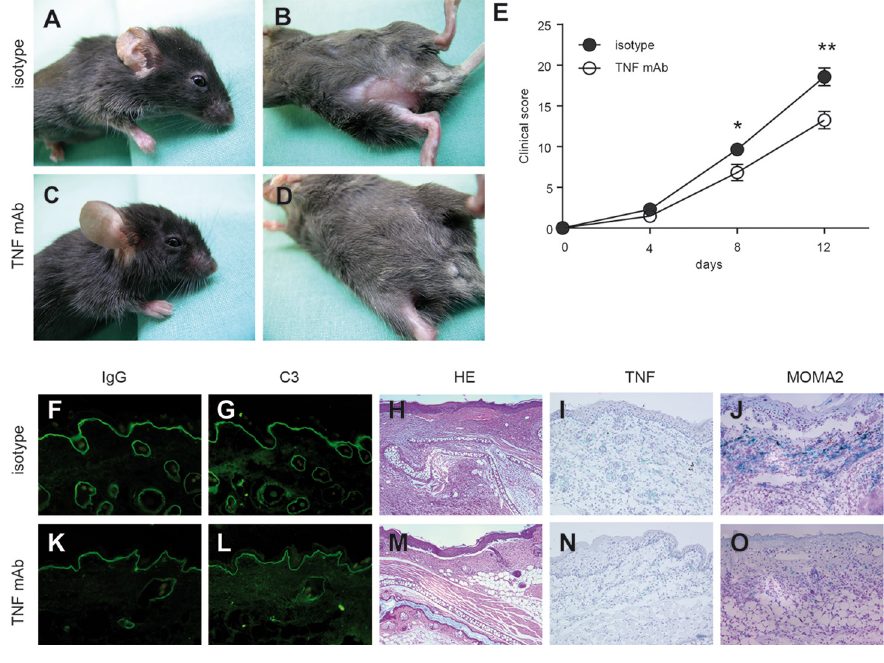
Figure 2. Prophylactic TNF blockade reduced the extent of skin disease in antibody